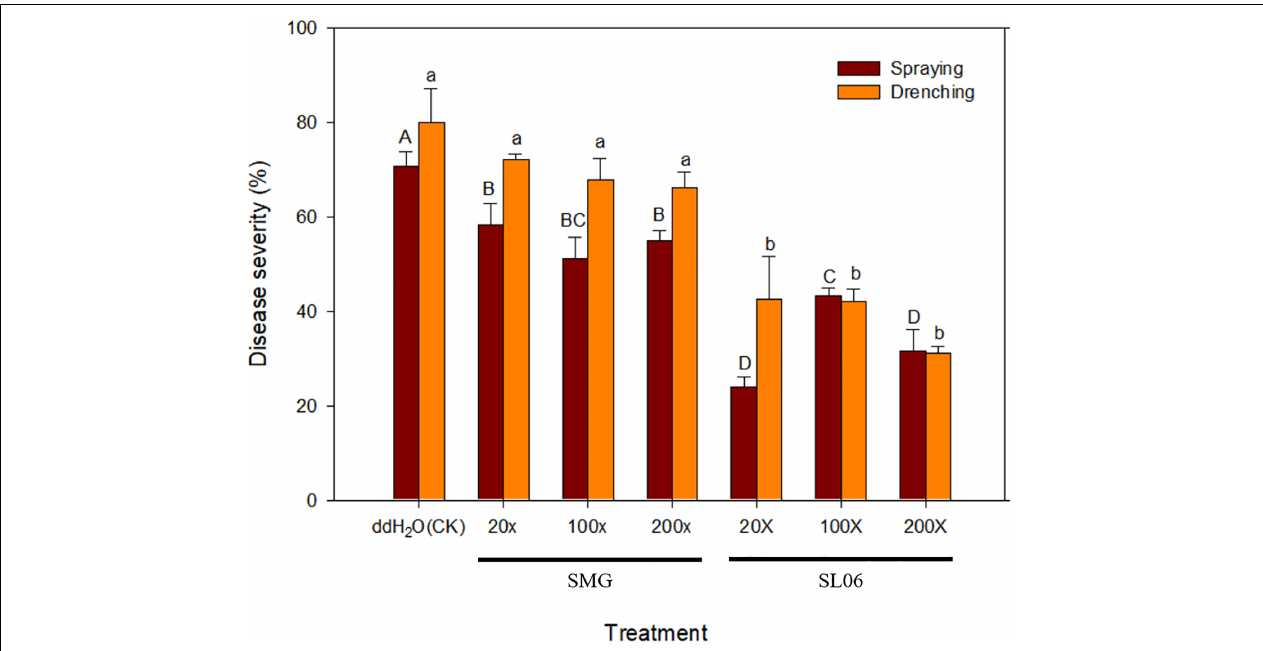
FIGURE 7 | Effect of different dilutions of Streptomyces griseorubiginosus LJS06 culture filtrate (SL06) on cucumber anthracnose severity. Diluted SL06 solutions were sprayed or drenched 1 day before inoculation. Means ( n = 6) for the same application method followed by different letters significantly differ ( p < 0.05) according to Fisher’s least significant difference test. Bar = standard